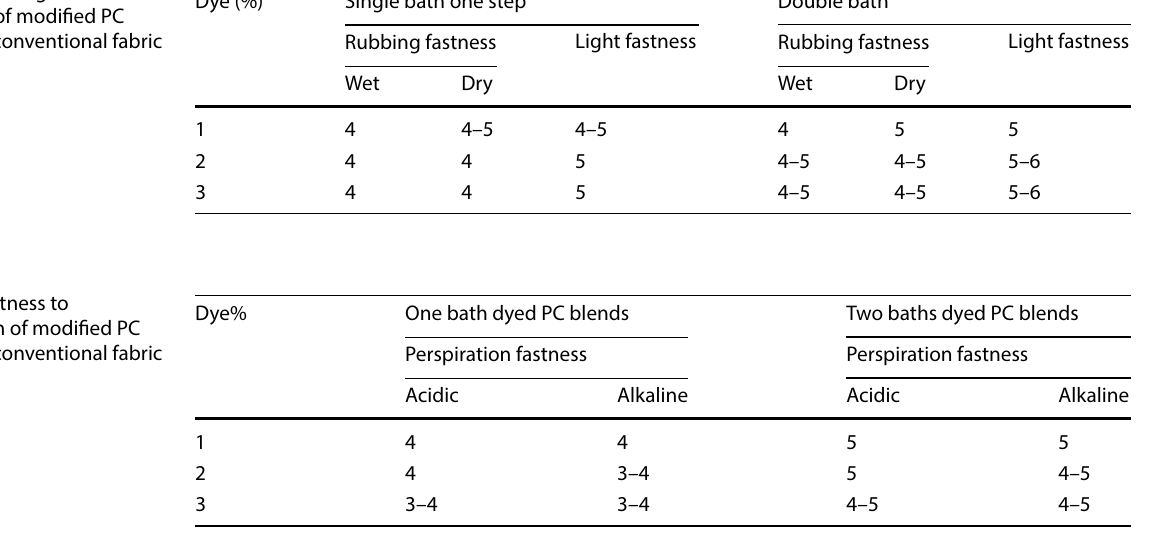
Table 5 Rubbing fastness properties of modified PC blend and conventional fabric dying